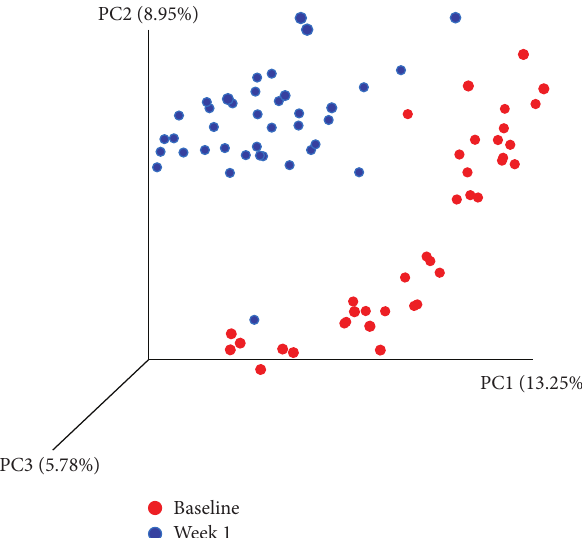
Figure 1: Unweighted principal coordinate analysis of the microbiota composition of the rats at baseline (after induction of T2D) and after one week of feeding the control (AIN) and 9 different treatments.